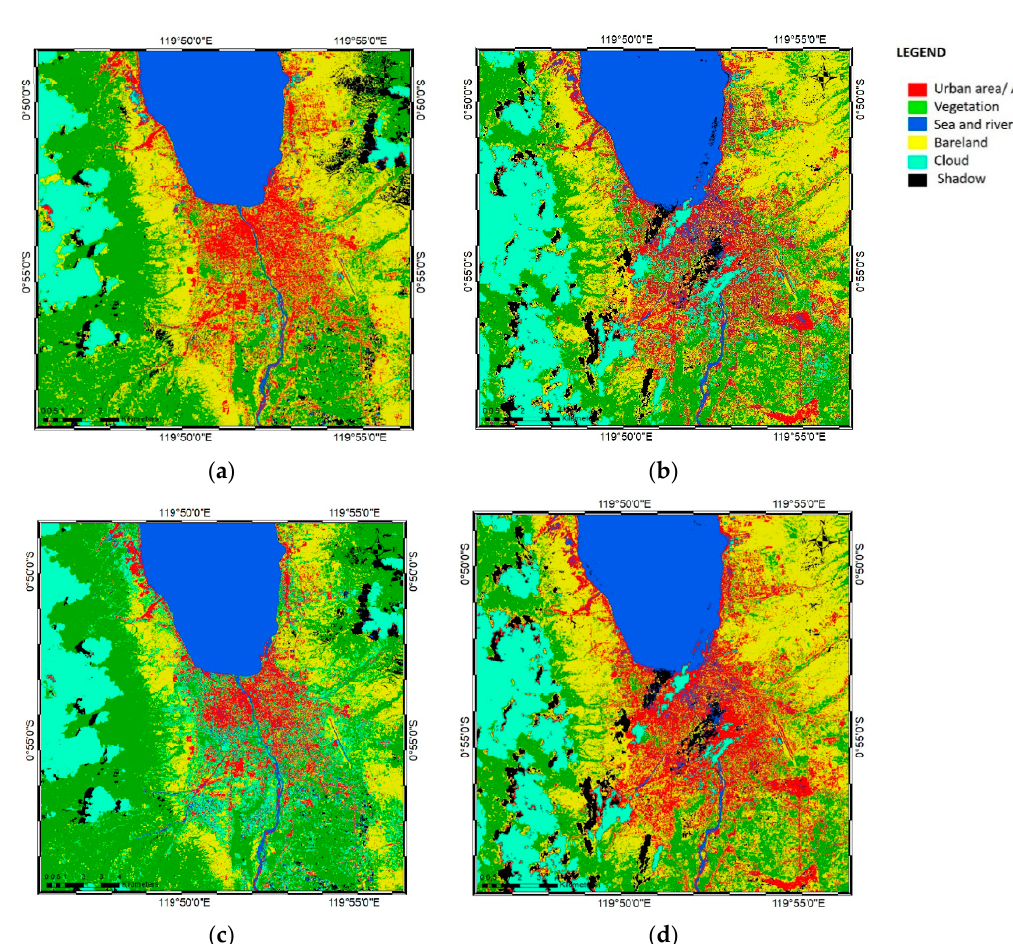
Figure 10. Sentinel ‐ 2 classification image results of ( a ) ANN classifier pre ‐ earthquake occurrence, Figure 10. Sentinel-2 classification image results of ( a ) ANN classifier pre-earthquake occurrence, ( b ) ANN classifier post ‐ earthquake occurrence, ( c ) SVM classifier pre ‐ earthquake occurrence, and ( b ) ANN classifier post-earthquake occurrence, ( c ) SVM classifier pre-earthquake occurrence, ( d ) SVM classifier post ‐ earthquake occurrence in Palu, Indonesia. and ( d ) SVM classifier post-earthquake occurrence in Palu,